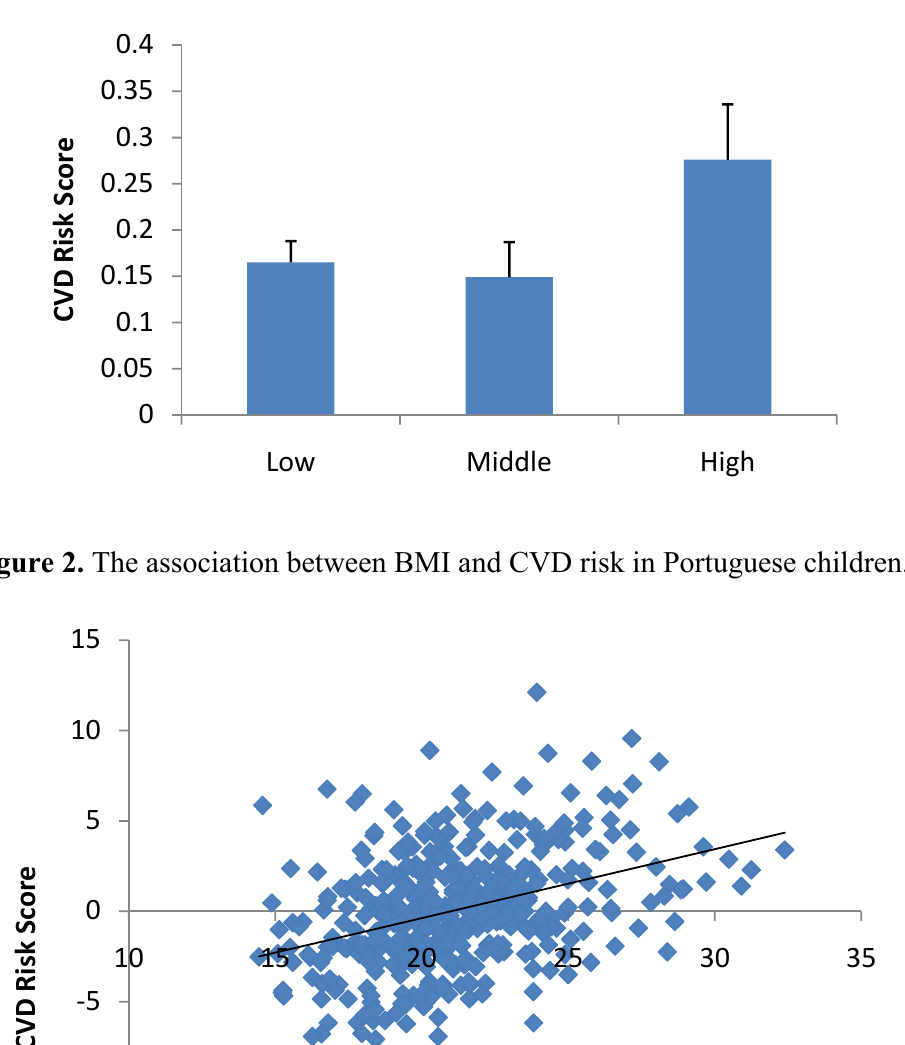
Figure 1. Mean ± S.E. of CVD risk score of Portuguese children with low, middle and high level of parental education.